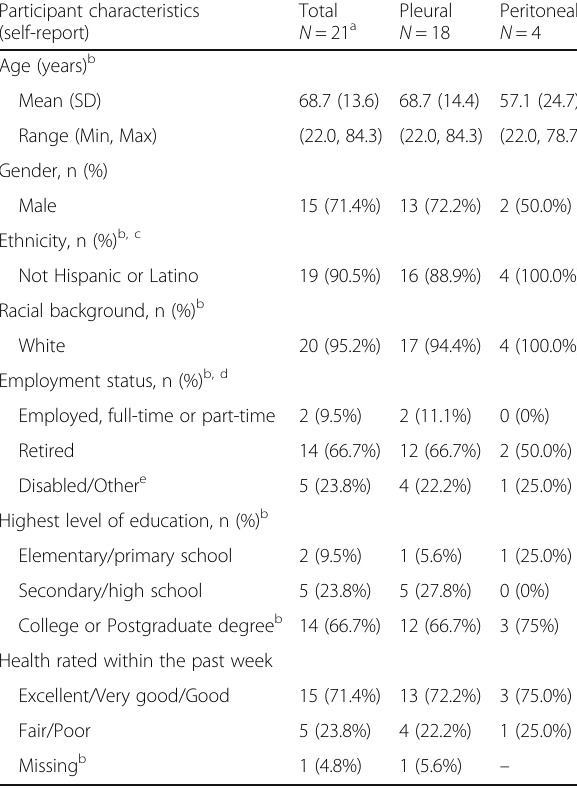
Table 2 Clinician-reported participant characteristics Clinical